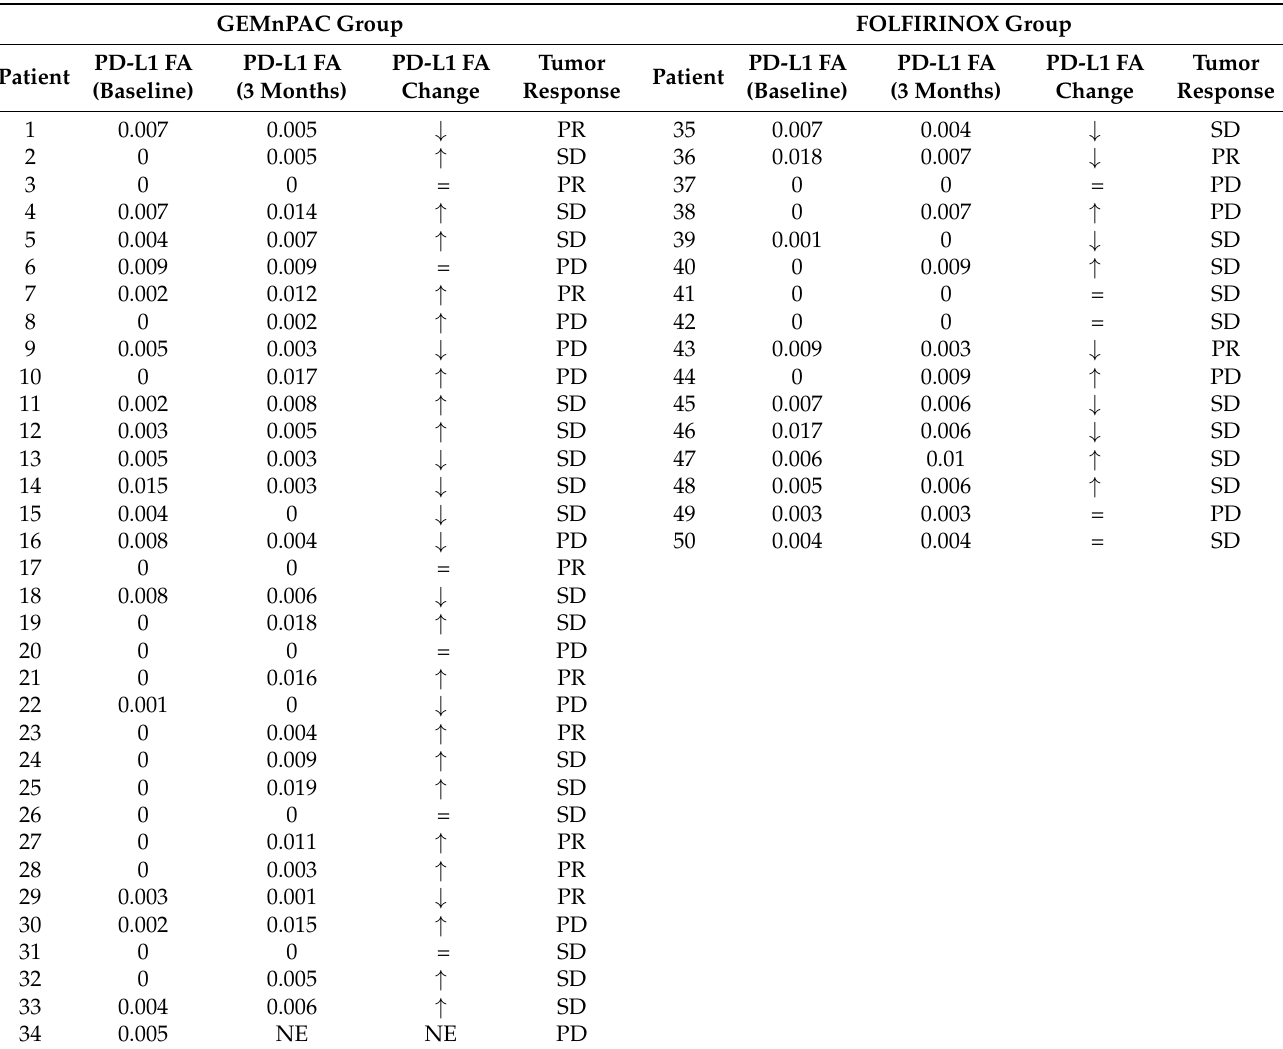
Table 2. PD-L1 fractional abundance (FA) in plasma-derived MVs at baseline and at first tumor assessment (3 months) vs. tumor response in patients treated with GEMnPAC or FOLFIRINOX. GEMnPAC Group FOLFIRINOX Group PD-L1 FA PD-L1 FA Tumor Patient Patient (Baseline) Response